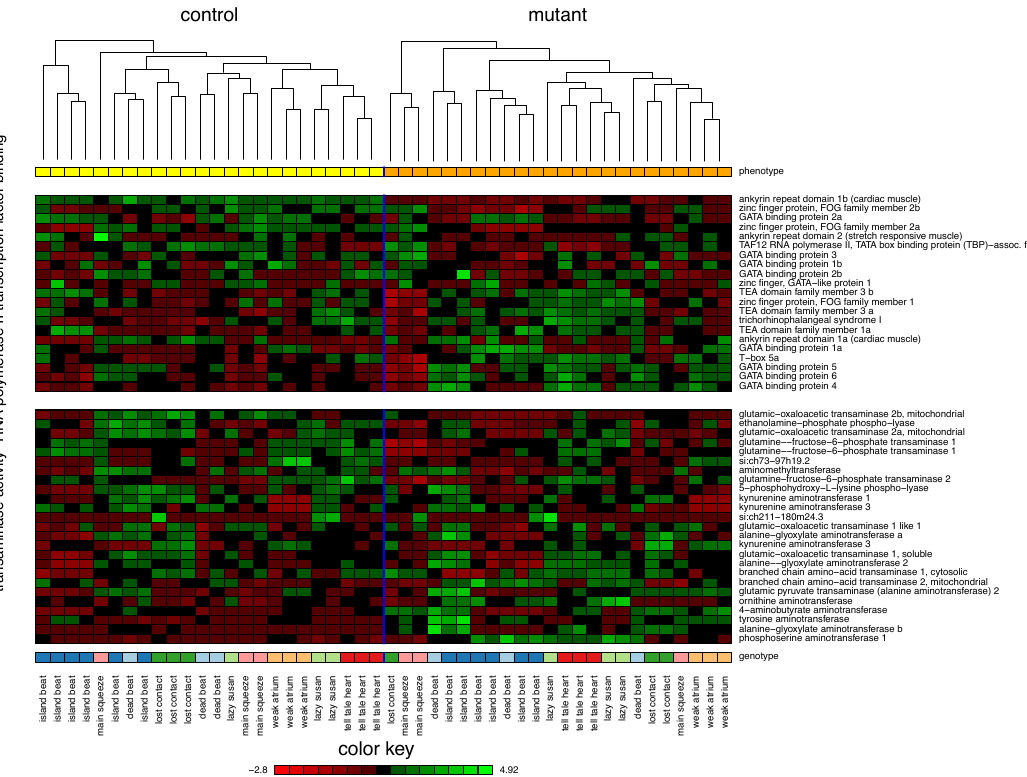
Figure 1. Heatmap of the two most frequently selected GO terms ( RNA polymerase II transcription factor binding (55.0%) and transaminase activity (42.0%)) in zebrafish. The figure provides the gene expression levels of the genes these terms comprise. Within each term, the genes are ordered according their Spearman correlation to the class label (mutant/control). Each gene was z -transformed individually. Within each class, hierarchical clustering (average linkage) was used to organize the samples. The RNA-Seq profiles represent the term transaminase activity by 25 markers. Transaminases